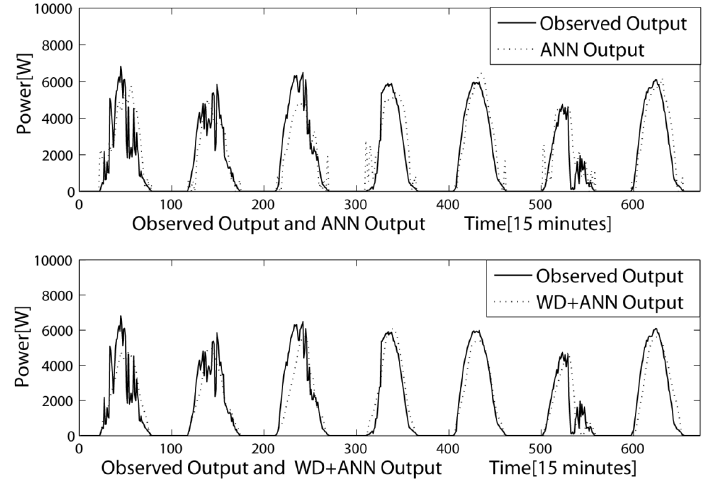
Figure 10. Comparison of forecasted results.